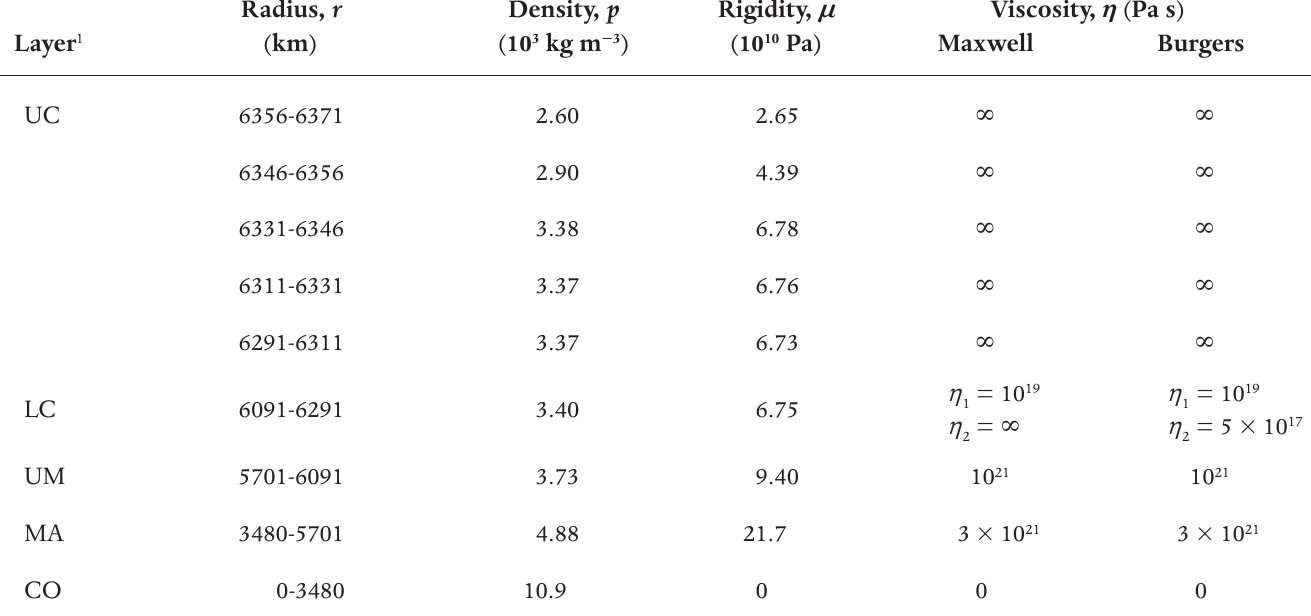
Table 1. Summary of the rheologies used in the synthetic case study ( 1 UC: Upper crust, LC: Lower crust, UM: Upper mantle, MA: Mantle, CO: